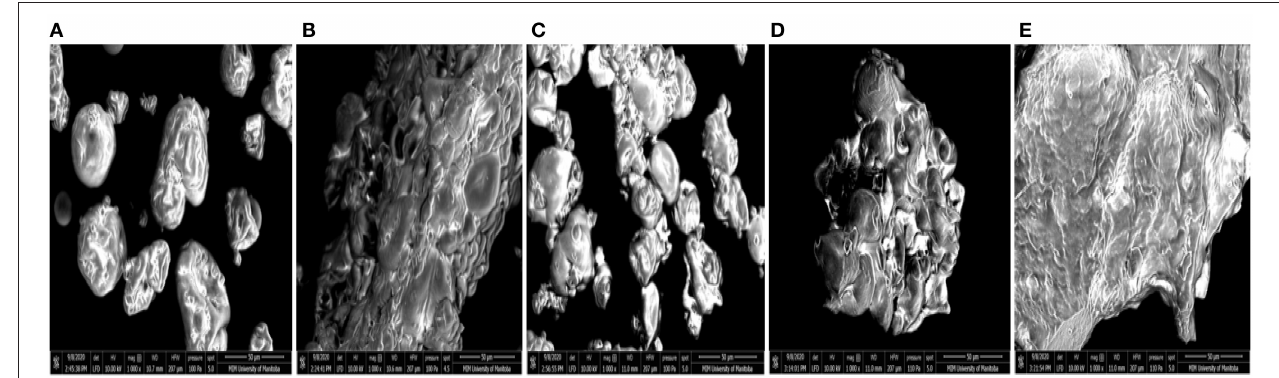
FIGURE 3 | Scanning electromicrographs of: (A) pea protein concentrate (PPC), (B) FT3, (C) FT5, (D) FT7, and (E) FT9 at 1,000 × magnification. PPC was heated at 100 ◦ C and varying pH, centrifuged, and the supernatant passed consecutively through 30 and 50 kDa membranes. The final retentate from the 50 kDa membrane was collected as FT3, FT5, FT7, and FT9 for heat treatments at pH 3.0, 5.0, 7.0, and 9.0,